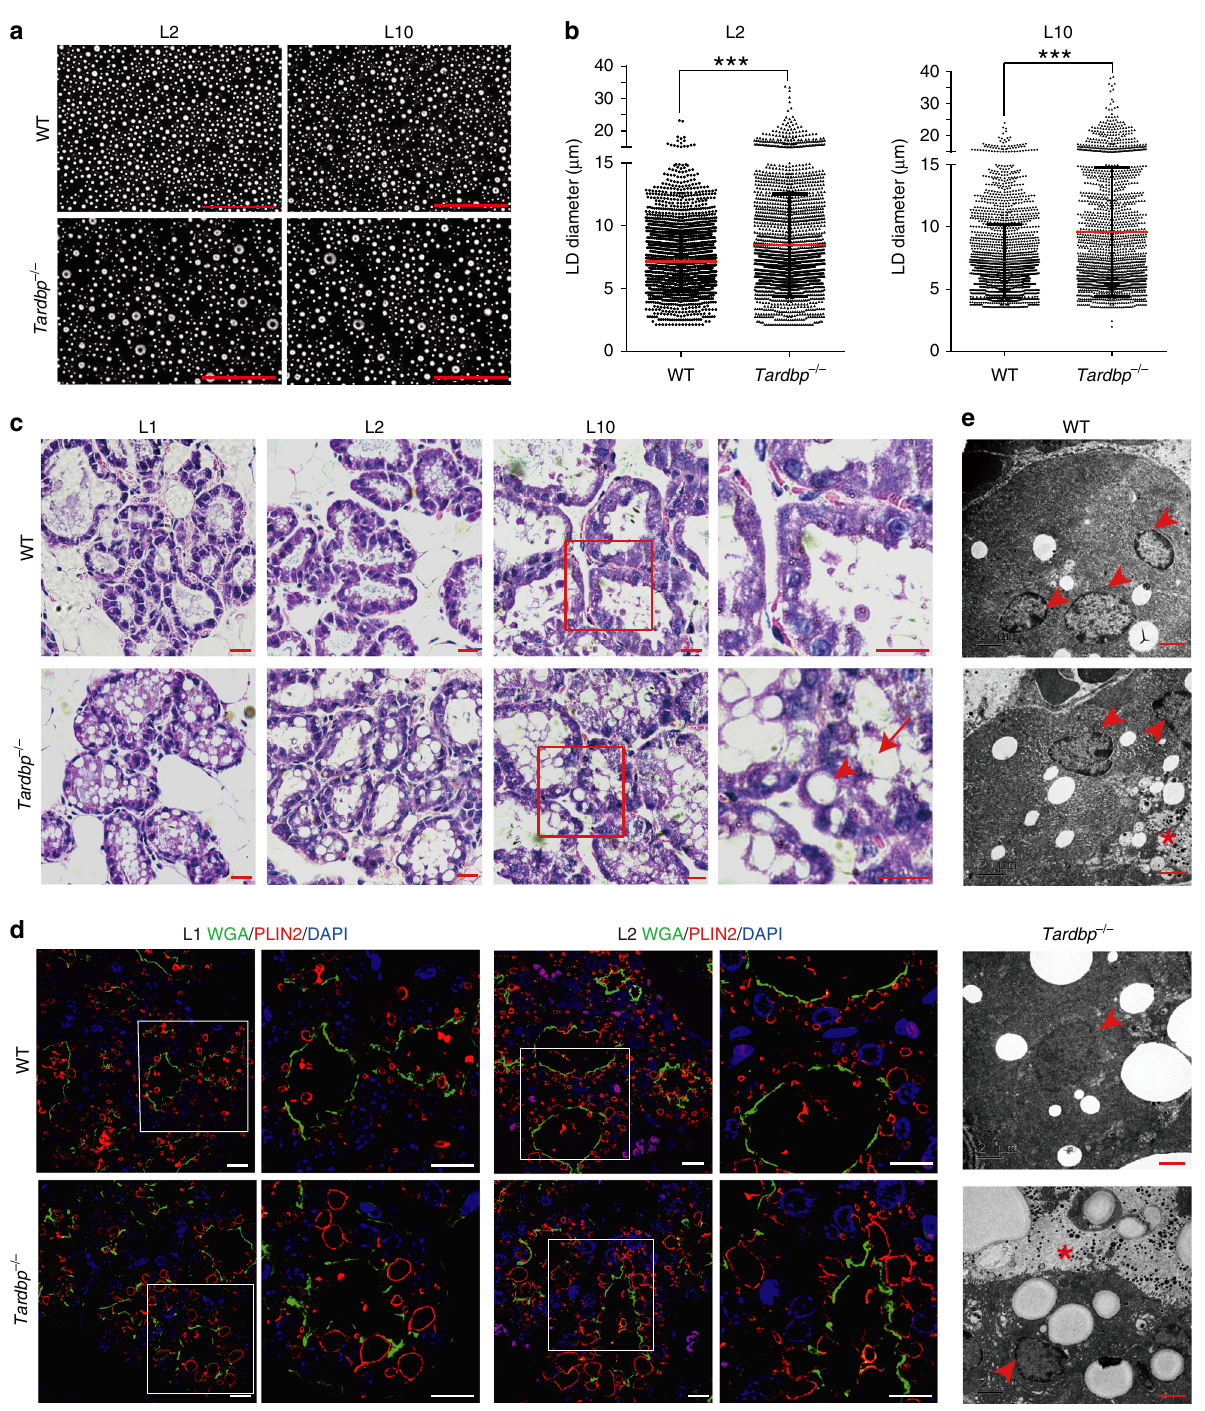
Fig. 3 Larger lipid droplets are present in MECs after knockout of Tardbp . a , b Phase contrast micrographs ( a ) and statistics ( b ) of milk fat globules (MFGs) from wild-type (WT) and Tardbp − / − mice analyzed using Image-Pro Plus 5.0 at lactation day 2 (L2) (left, n = 7 mice) or L10 (right, n = 6 mice). Scale bar: 100 μ m. Data are means± SD. Unpaired t test was used to evaluate statistical signi fi cance. *** P < 0.001. c Hematoxylin and eosin staining of mammary glands from WT and Tardbp − / − mice at L1, L2, and L10. Magni fi ed areas at L10 are shown in red boxes (left). Arrowhead shows cytoplasmic lipid droplets (CLDs) in cells and arrow shows large lipid droplets (LDs) in alveolar lumen. Scale bar: 20 μ m. d Immuno fl uorescence staining of adipophilin (PLIN2) (red) showing LDs in alveoli of mammary glands from WT and Tardbp − / − mice at L1 and L2. Sections were also stained with wheat germ agglutinin (WGA) (green) and 4 ′ ,6-diamidino-2-phenylindole dihydrochloride (DAPI) to outline luminal border or nuclei. Magni fi ed areas (right) are shown in white boxes (left). Scale bar: 10 μ m. e Electron microscopy images of mammary gland sections from WT and Tardbp − / − mice at L1. Arrowhead indicates nucleus and asterisk shows lumen of mammary glands. Scale bar: 2 μ m. Source data are provided as a Source Data fi